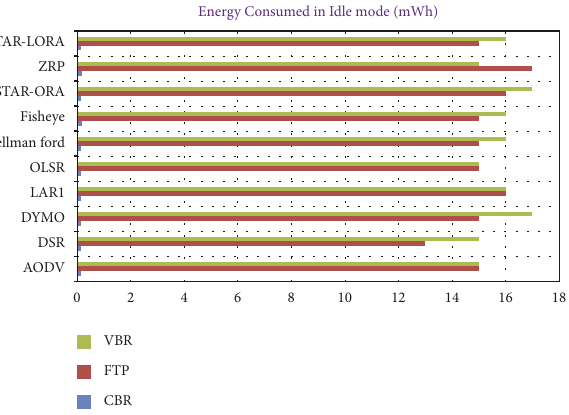
Figure 31: Energy consumed in idle mode of all routing protocols in CBR, FTP, and VBR applications.